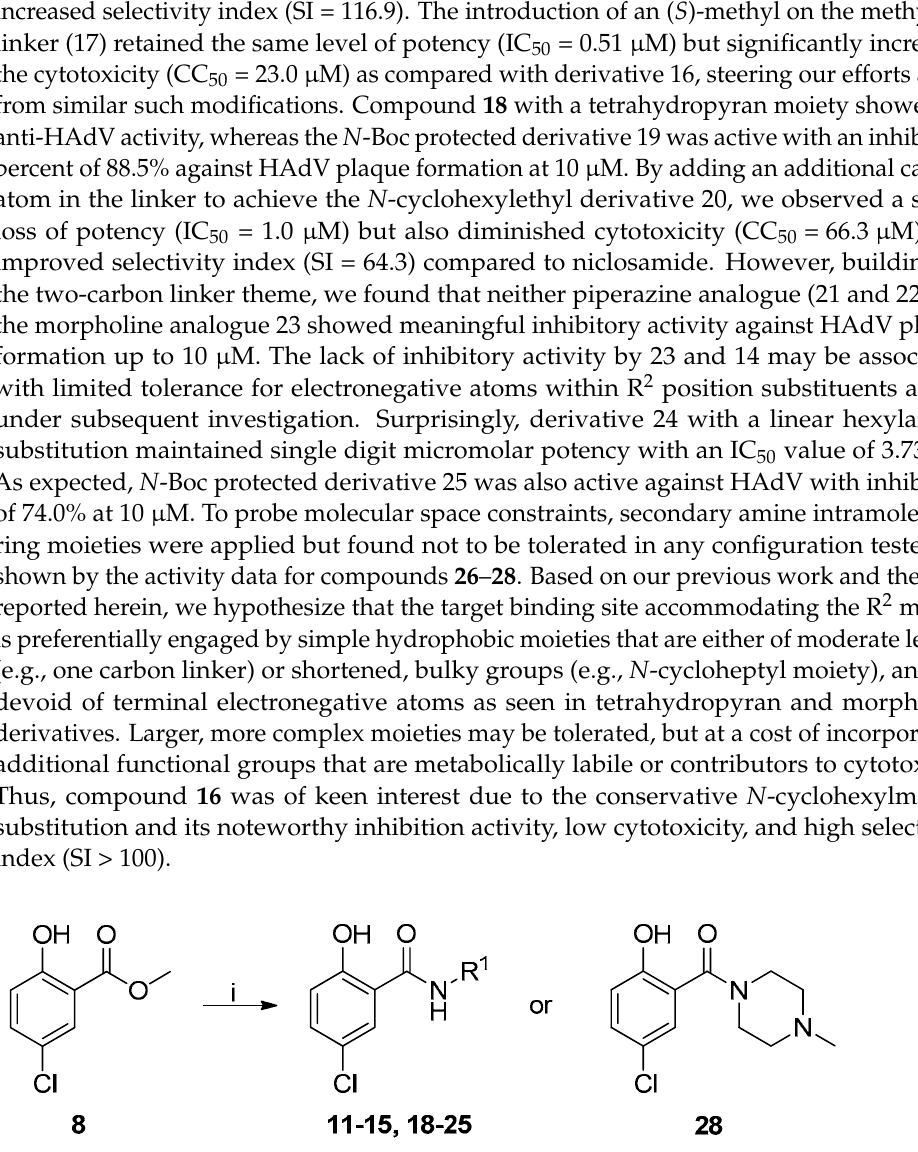
Figure 2. The drug design for this work, which highlights the discovery of new compound 16 (JMX0493) with both improved selectivity index and capability of inhibiting the escape from the endosome of the viral